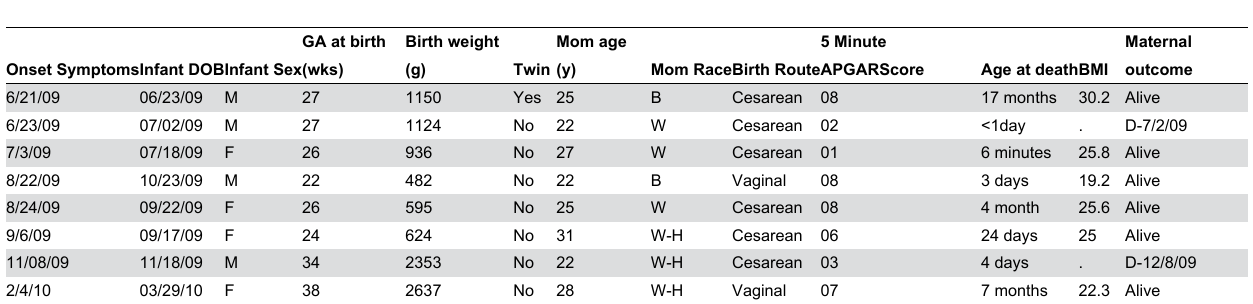
Table 4. Characteristics of infant and child deaths following live birth to mothers with pandemic influenza illness during pregnancy.